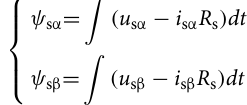
Vehicle system dynamics model.